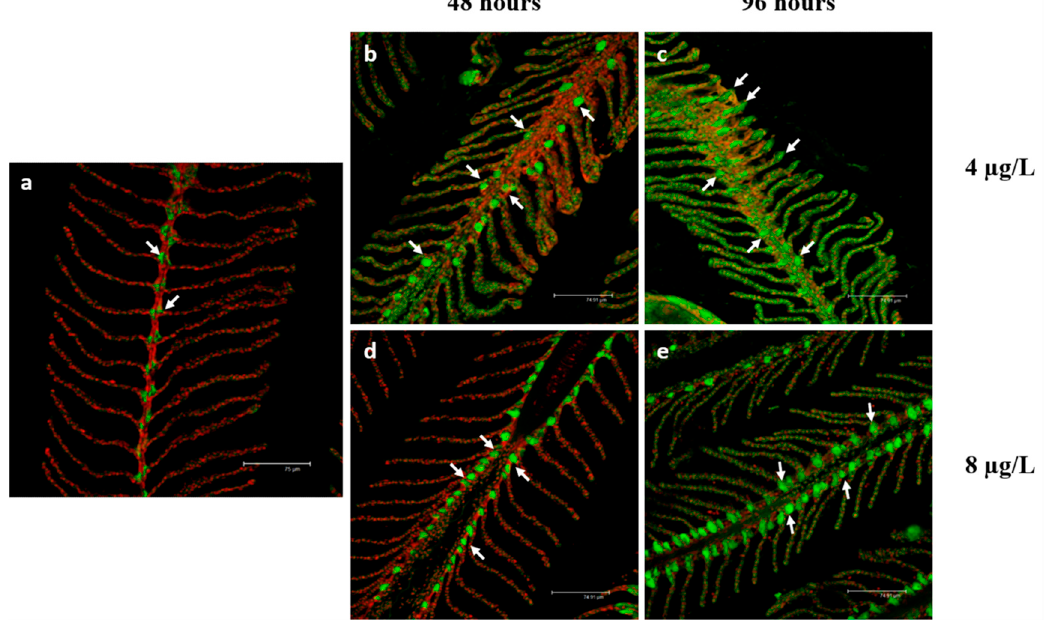
Figure 5. Confocal micrographs of T. pavo gill sections labeled with a mouse monoclonal antibody against Na + /K + -ATPase (green-FITC labeled); nuclei labeled with propidium iodide (red); ( a ) In basal condition, the Na + /K + -ATPase is located in the CCs of the interlamellar region (white arrows). After 48 ( b ) and 96 h ( c ) of exposure to 4 µg/L of CPF, the Na + /K + -ATPase immunoreactivity slightly increases compared to the basal condition, and after 96 h of exposure, the signal is also observed in the secondary lamellae (white arrows). After 48 ( d ) and 96 h ( e ) of exposure to 8 µg/L of CPF, the Na + /K + -ATPase immunoreactivity further increase compared to the basal condition (white arrows). All bar scales 75 µm.